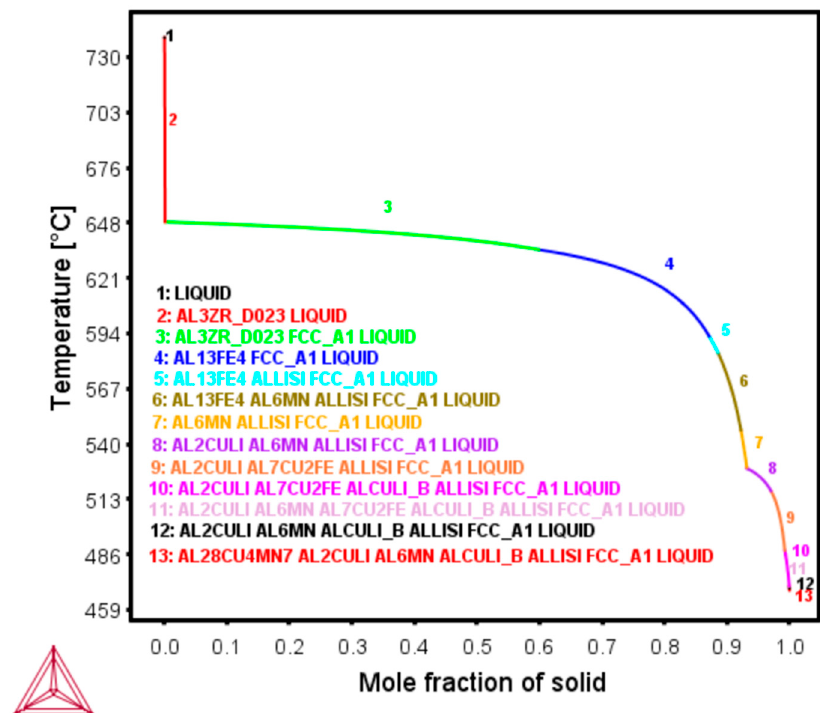
Figure 5. Scheil non-equilibrium simulation (TCal6), predicting T 1 and T B formation temperatures .